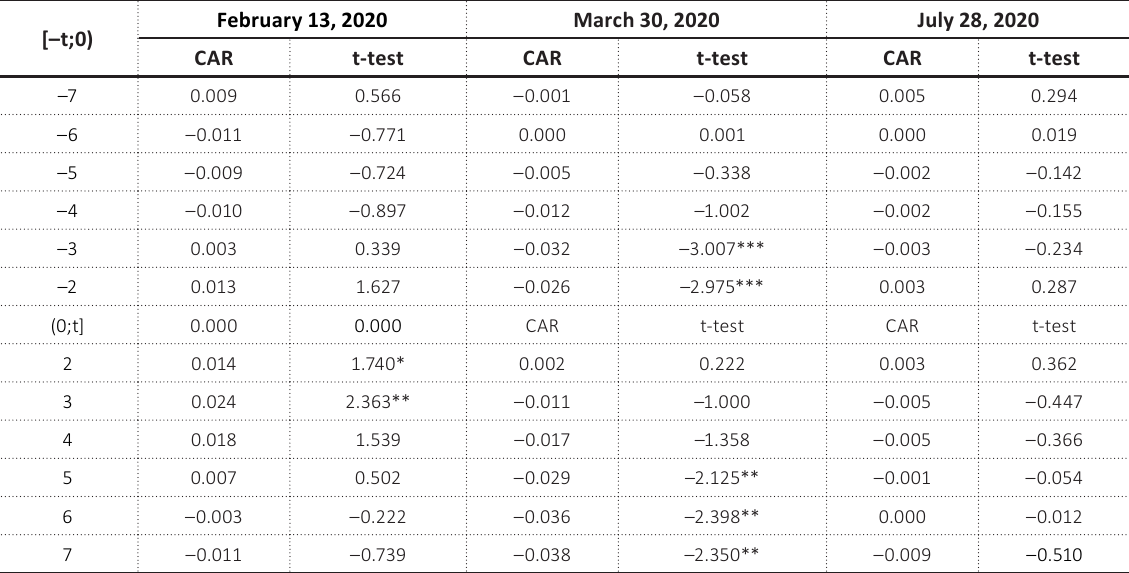
Table 2. Cumulative abnormal returns (CAR) and t-test results for three lockdowns due to COVID-19 in